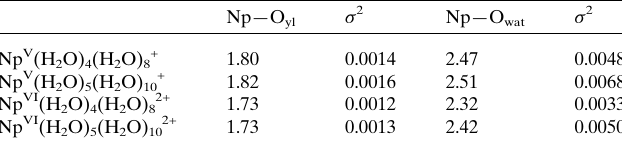
Table 2 DFT calculations of Np—O bond distances (average values in A˚ ) and Debye–Waller factor (cid:4) 2 (A˚ 2 ) in Np V and Np VI hydrated clusters with four and five coordinated water